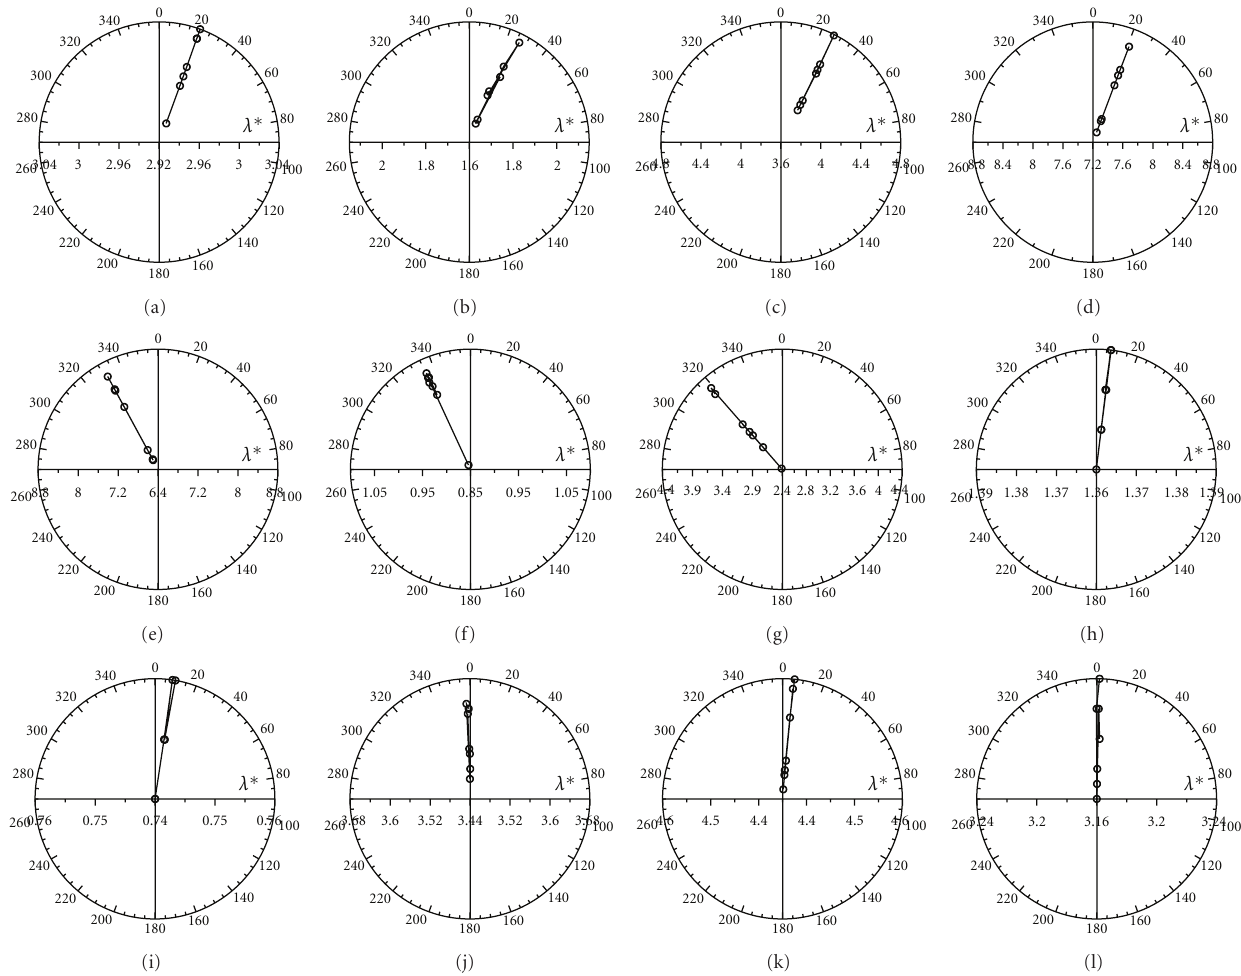
Figure 8: The diagrams of λ ∗ and α with pressure for sample YN1. (a)–(l) represent the diagrams at the e ff ective depths of 1.5 mm, 4.5 mm, 7.5mm, 10.5 mm, 13.5 mm, 16.5 mm, 19.5 mm, 22.5 mm, 25.5 mm, 28.5mm, 31.5mm, and 34.5 mm.